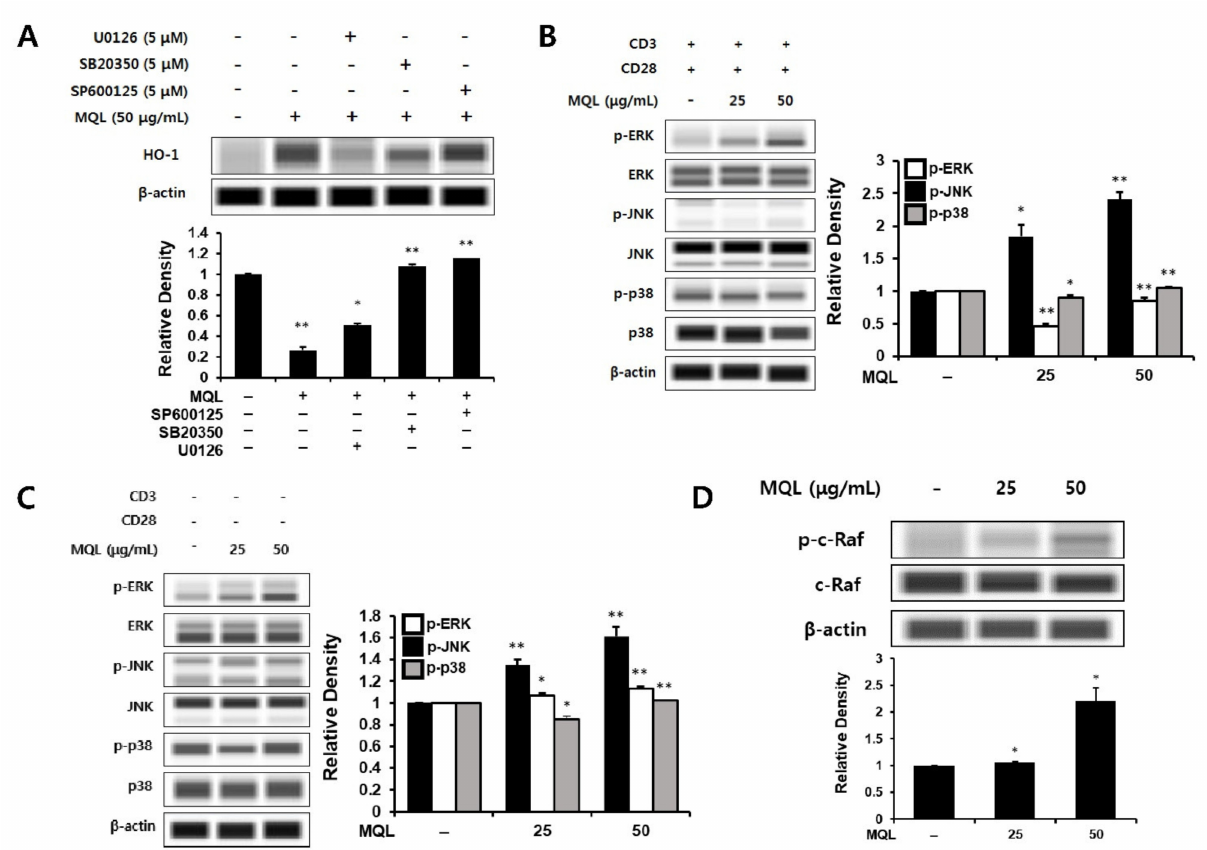
Figure 4. Effects of MQL on MAPK signaling pathways. ( A ) CD4 + T cells were isolated from splenocytes and pre-treated with U0126 (5 µ M), SB20350 (5 µ M), or SP600125 (5 µ M) for 1 h and then treated with MQL for 24 h to detect HO-1 expression in CD4 + T cells. ( B ) To analyze MAPK phosphorylation induced by MQL, CD4 + T cells were pre-treated with MQL for 2 h before stimulation with anti-CD3 (1 µ g/mL) and anti-CD28 antibodies (1 µ g/mL). CD4 + T cells were treated with MQL for 2 h without stimulation, and ( C ) MAPK phosphorylation and ( D ) C-Raf phosphorylation were detected using Western blot. Data are representative of three independent experiments. Results are shown as mean ± SD. * p < 0.05, ** p < 0.01, between the MQL-treated and non-treated